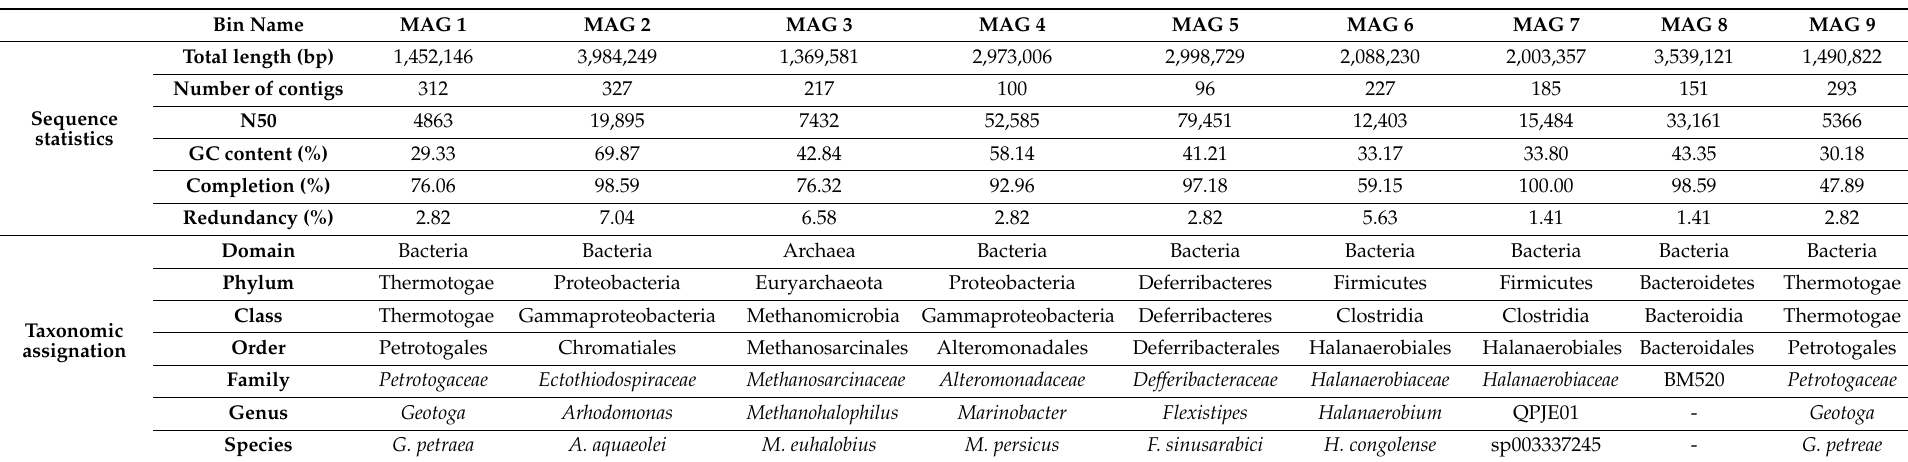
Table 1. Metagenome parameters and taxonomic assignments of 9 MAGs from oil reservoir formation